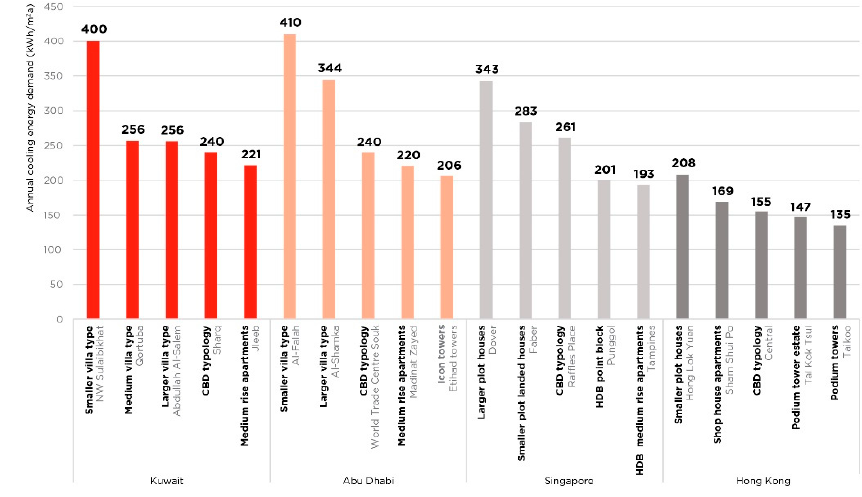
Figure 7. Annual cooling energy need in the 20 typologies.